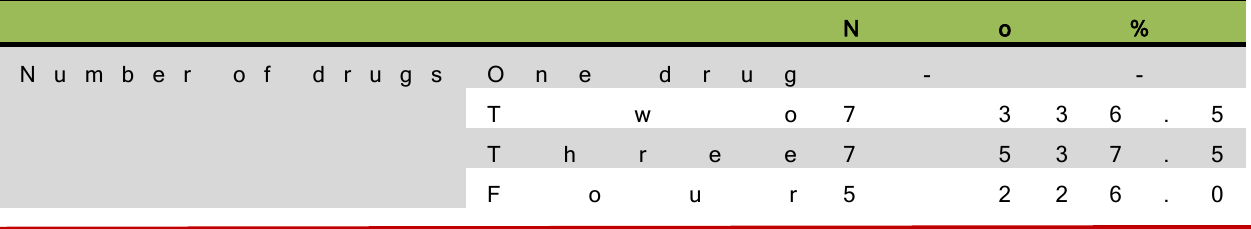
Table5: The distribution of patients according to number of drugs used by patients and the duration of treatment. N u m b e r